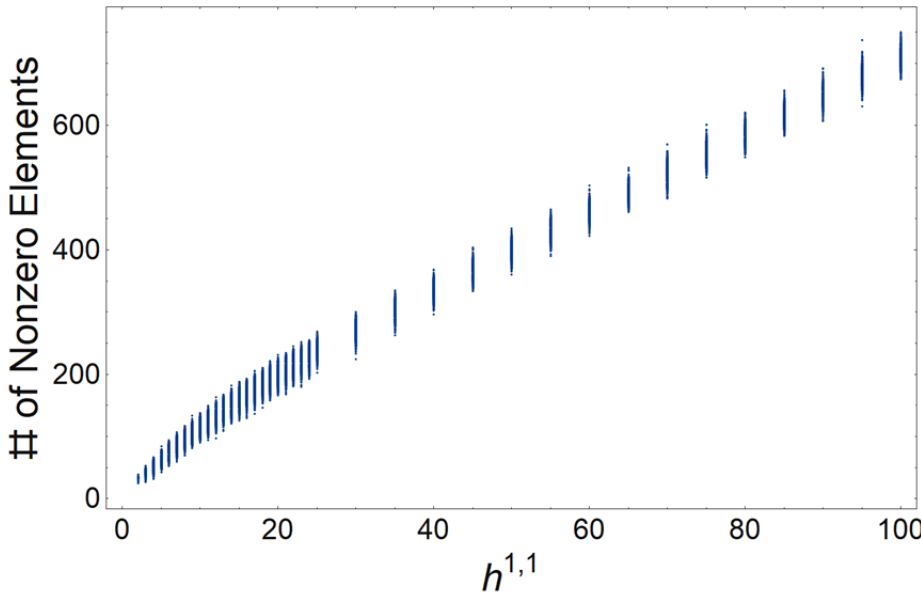
Figure 1. Number of nonzero entries of (cid:20) ABC , cf. (2.9), vs. h 1 ; 1